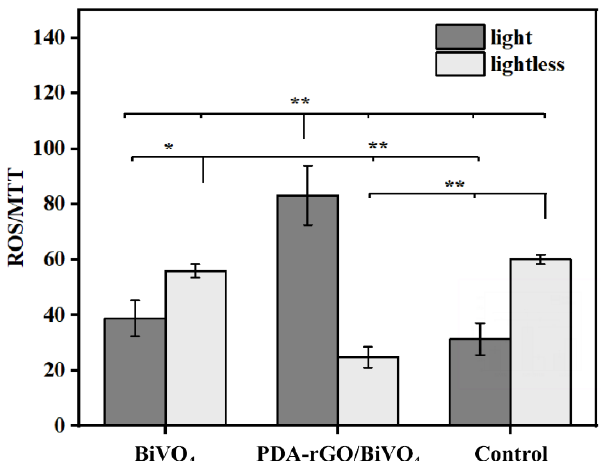
Figure 3. The antibacterial effect of PDA-rGO/BiVO 4 and BiVO 4 with or without xenon light irradiation was determined by flat colony counting ( A ) and MTT assay ( B ) (* p < 0.05 and ** p < 0.01 indicates significant difference).